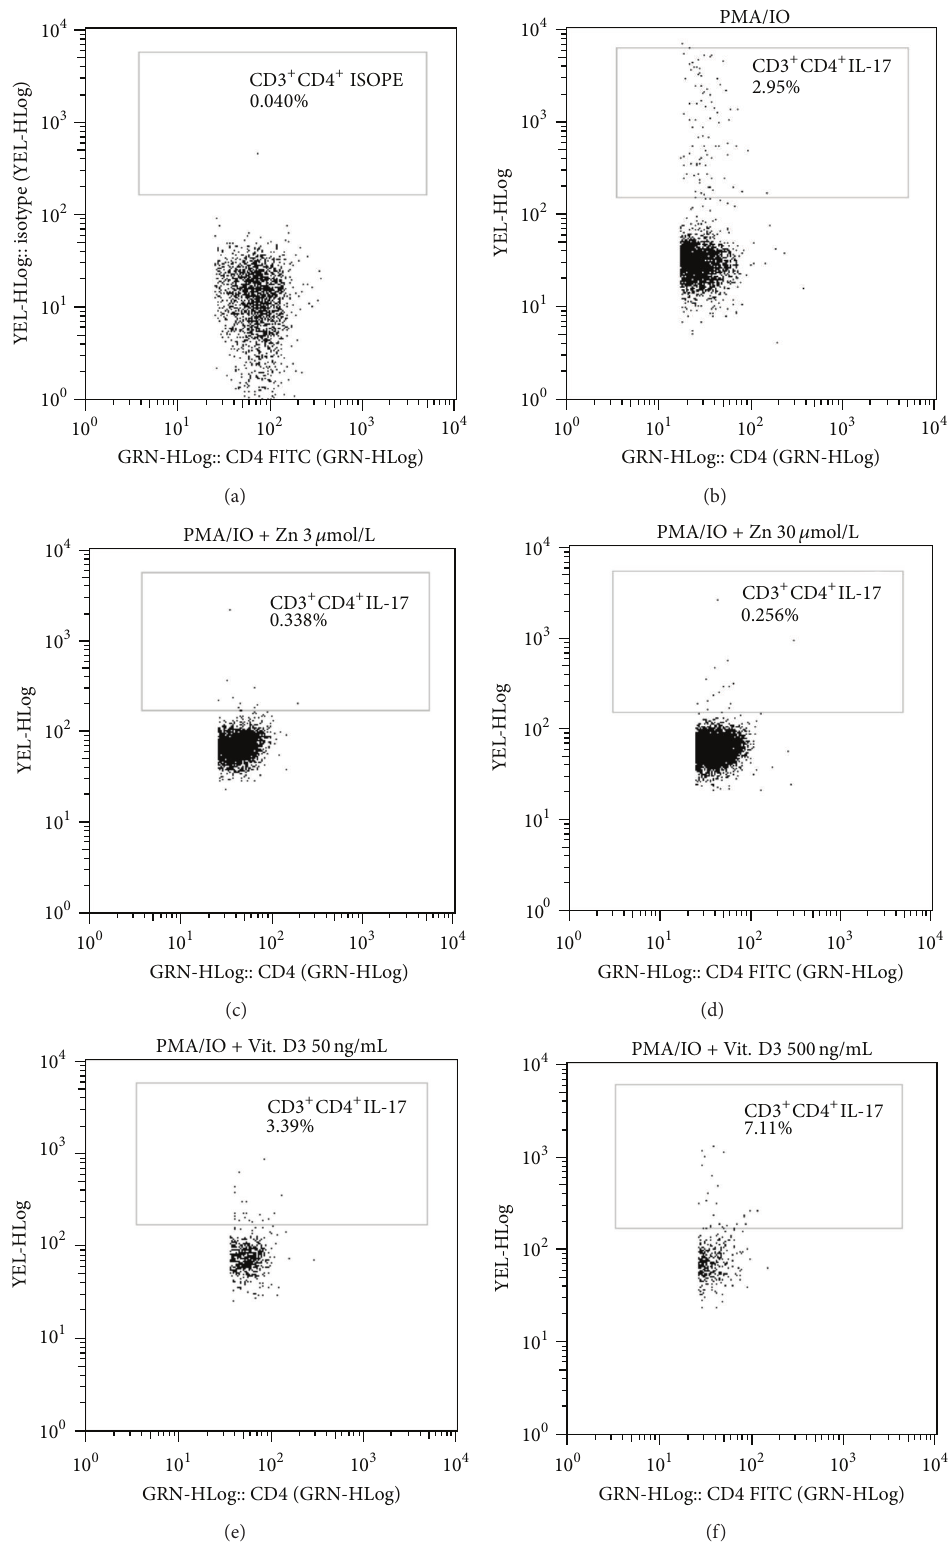
Figure3:RepresentativeflowcytometryplotsforonepatientareshownandgatingofCD3 + CD4 + ISOPEisindicated(a).Phorbol12-myristate 13-acetate and ionomycin-stimulated peripheral blood mononuclear cells were stained and analyzed for IL-17 production (b). Inhibitory effect of Zn on IL-17 production with 3 𝜇 mol/L concentration (c) and 30 𝜇 mol/L concentration (d). Vitamin D3 effect on IL-17 production with 50 ng/mL concentration (e) and 500 ng/mL concentration